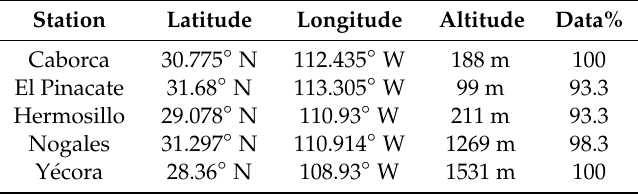
Table 1. Selected meteorological stations in Sonora (location and altitude)